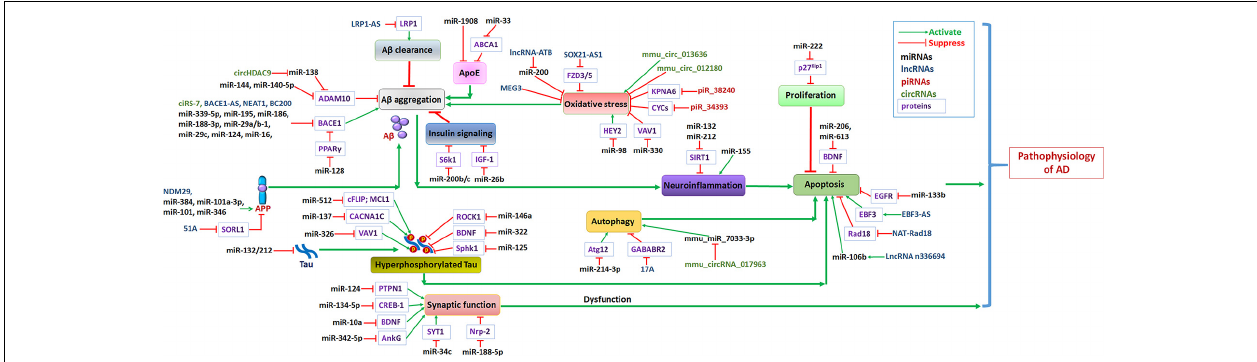
FIGURE 2 | Non-coding RNA networks in AD. Abnormal levels of A β in the brains of AD patients formed plaques, and further induced neuroinflammation and promotes AD progression. The hyperphosphorylation of tau protein results in formation of intracellular neurofibrillary tangles induced neuron apoptosis. Oxidative stress, abnormal insulin signaling pathway or apoE functions lead to A β aggregation, further promoted AD progression. Growing evidence confirmed that autophagy dysfunction induce neuron apoptosis may accelerate AD progression. Green arrows represent the effects of activating downstream target genes, and red arrows represent the effects of suppressing downstream target